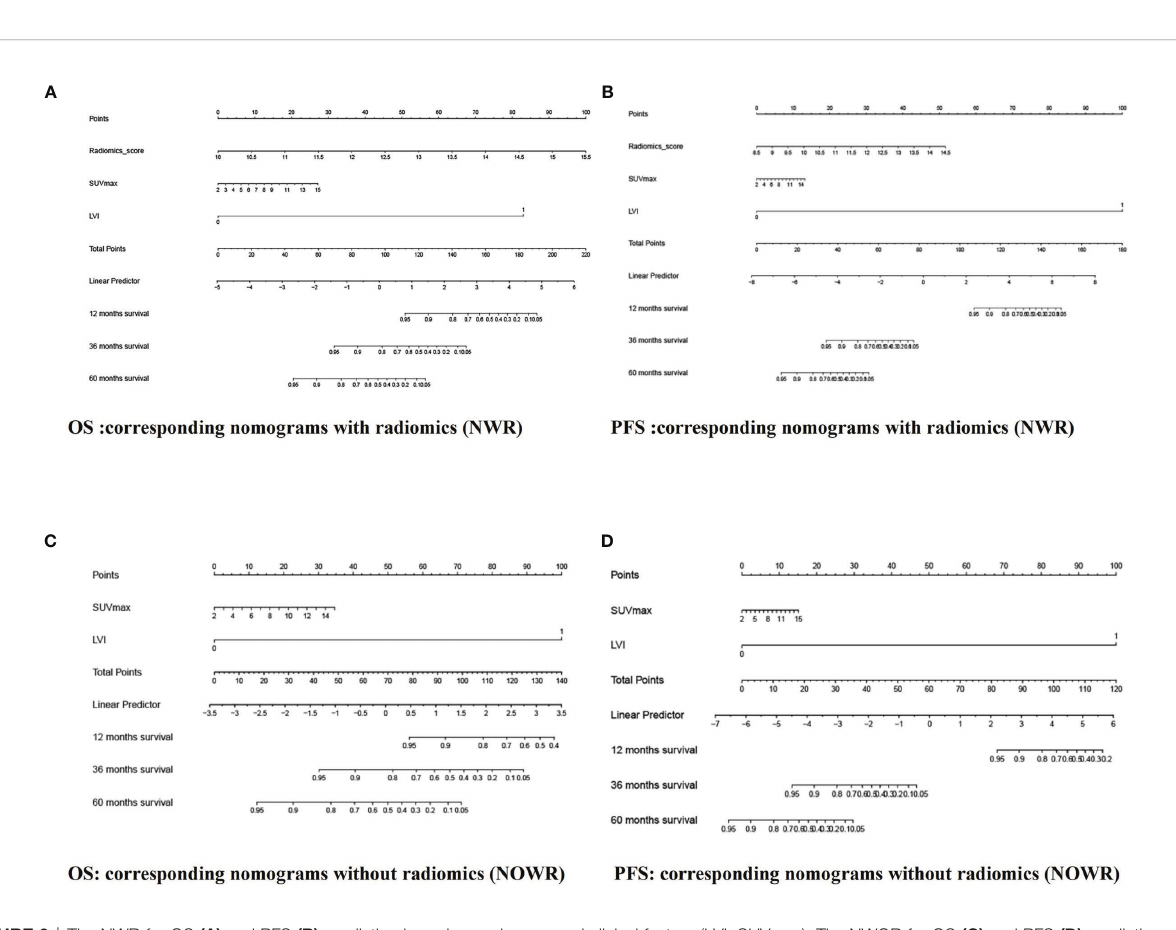
FIGURE 3 | The NWR for OS (A) and PFS (B) prediction based on rad-score and clinical factors (LVI, SUVmax). The NWOR for OS (C) and PFS (D) prediction based on clinical factors (LVI,